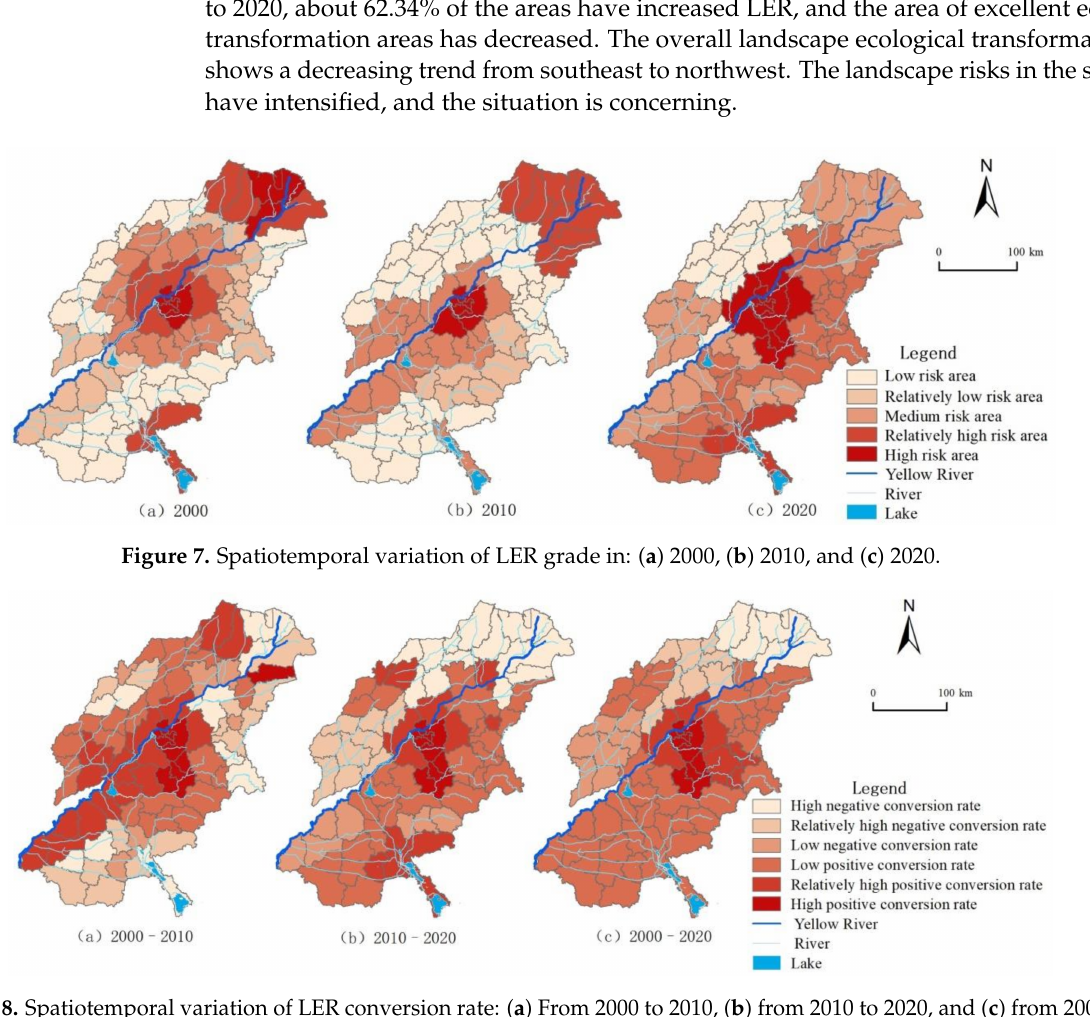
Figure 8. Spatiotemporal variation of LER conversion rate: ( a ) From 2000 to 2010, ( b ) from 2010 to 2020, and ( c ) from 2000 to